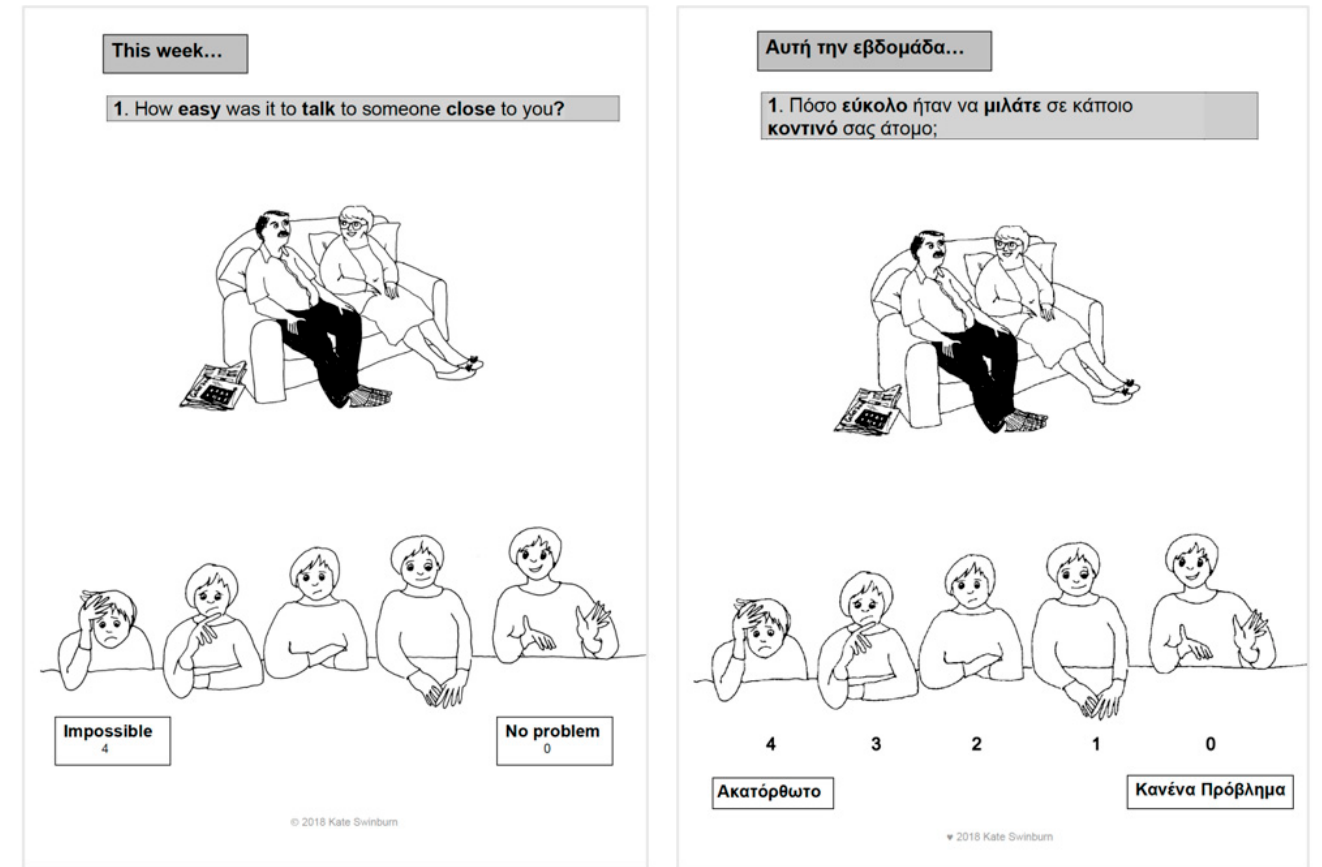
Figure 1. Example of item scoring of the British ( left ) and Greek ( right ) version, where the numbers of the Likert Scale were added under each illustration.